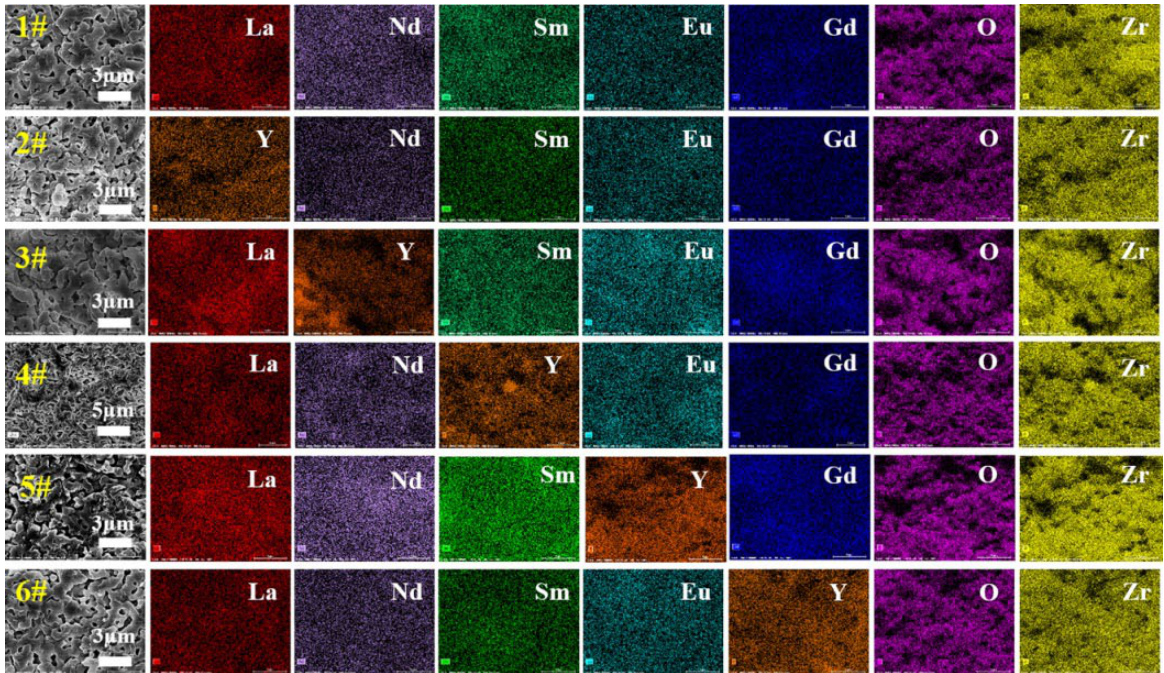
Fig. 4 Elemental mappings of the ceramics (1#–6#) after sintering at 1500 ℃ for 3